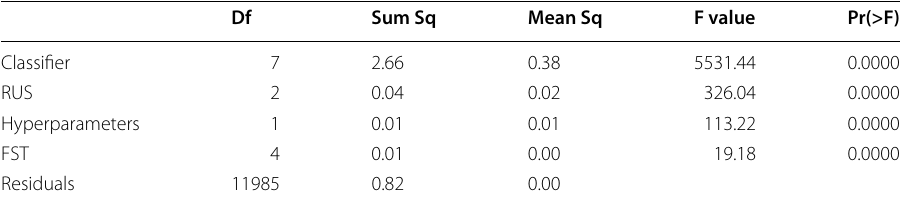
Table 7 ANOVA for classifier, RUS, hyperparameters and FST as factors of performance in terms of